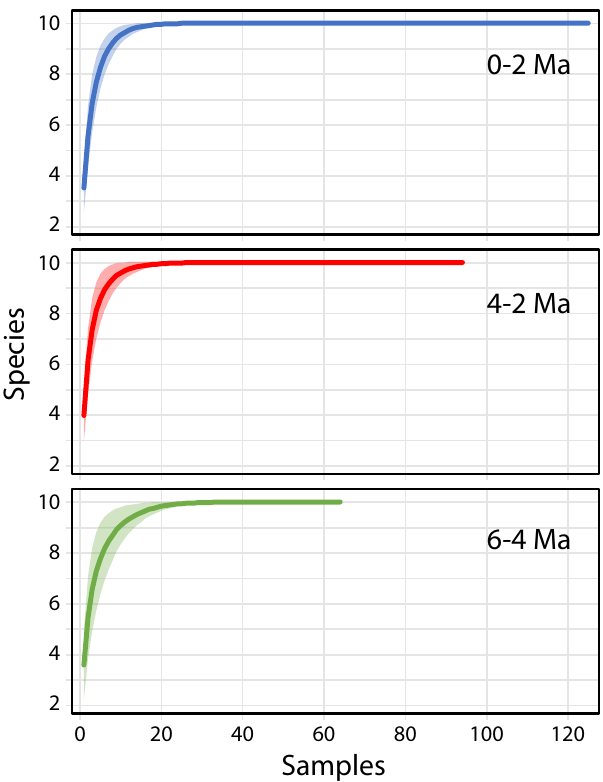
Figure 2. Rarefaction curves for the ten commonest cupuladriid species from fossil and Recent samples in the southwestern Caribbean grouped in three time-bins. Shaded area represent 95% Confidence Intervals. Calculated using EstimateS 87